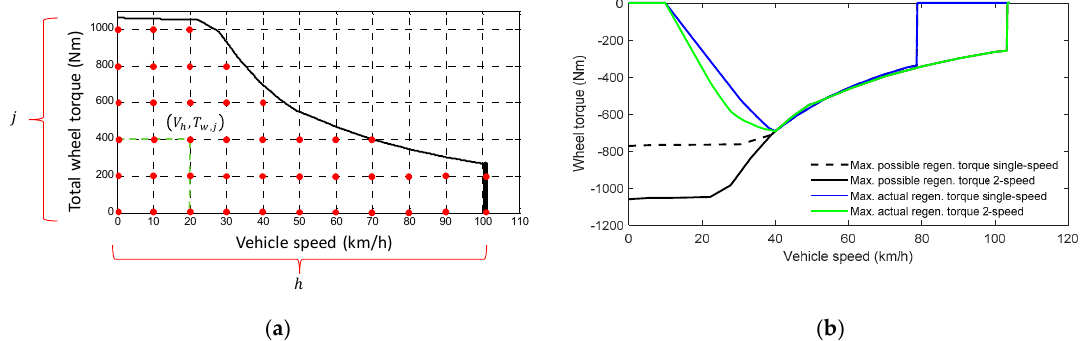
Figure 11. Features of the implemented optimization routine: ( a ) Examples of grid points; ( b ) Regenerative braking torque limits.